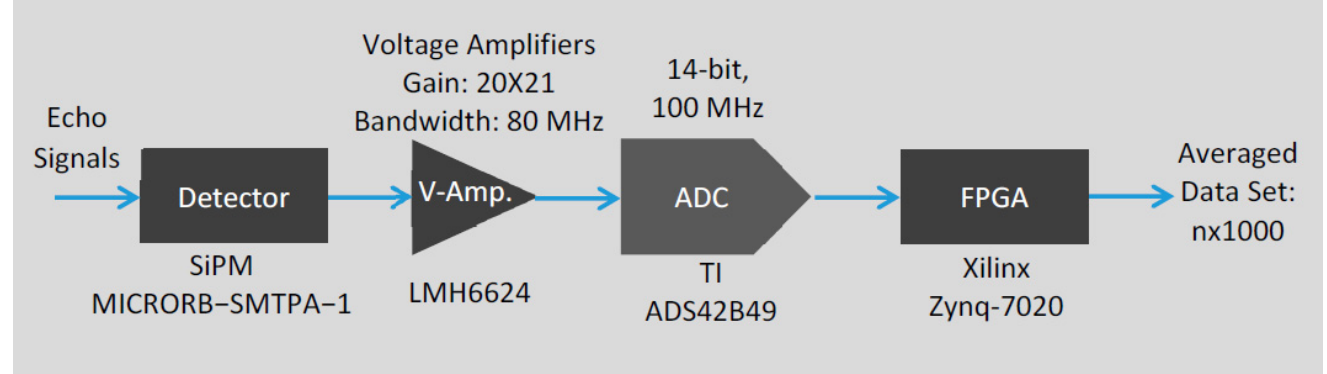
Figure 3. Block diagram of data acquisition part. SiPM is biased at the overvoltage of 10 volts.